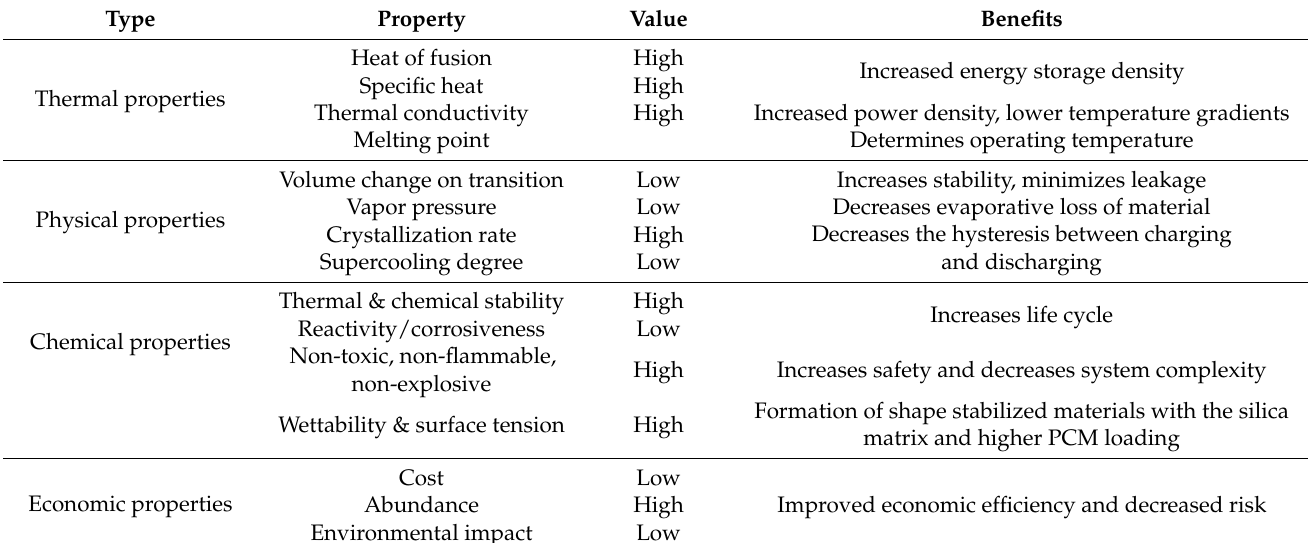
Table 2. Desired properties of porous silica–based phase change